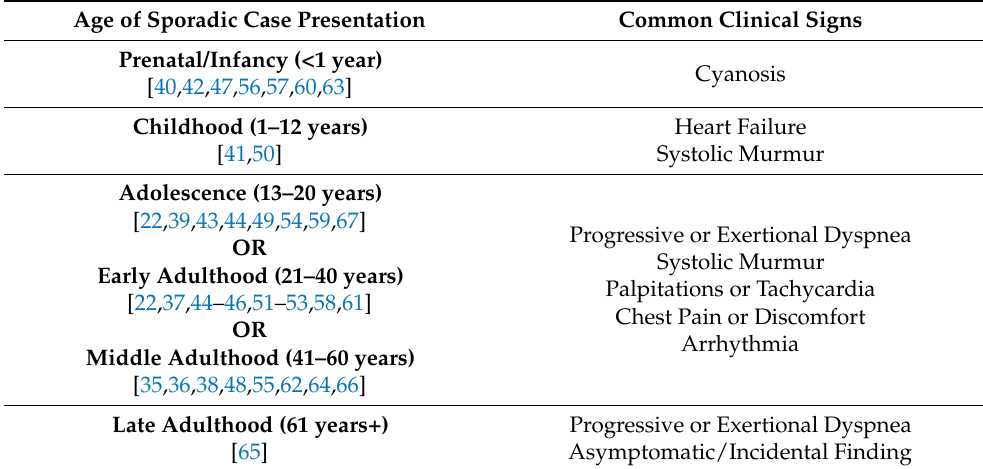
Table 1. Common clinical signs based on age of sporadic EA/LVNC case